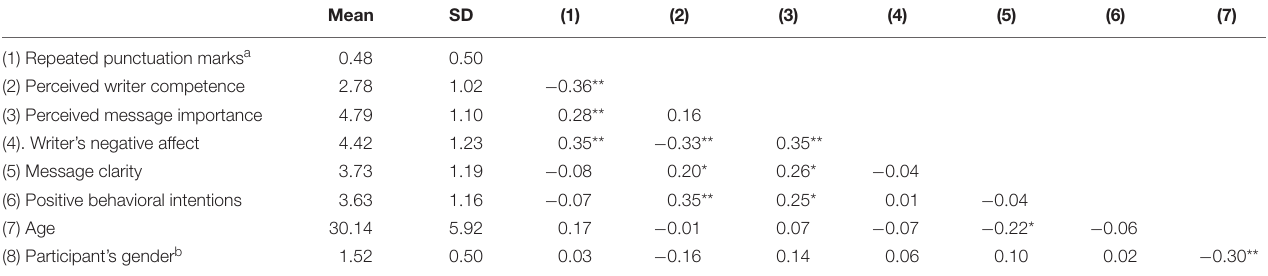
TABLE 2 | Descriptive statistic and correlations for Experiment 2.